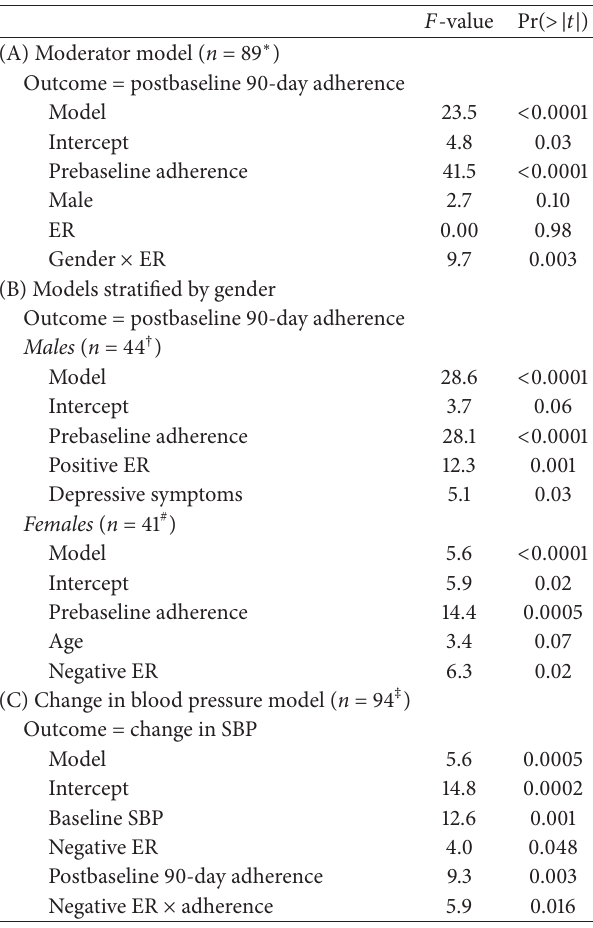
Table 1: Multivariate